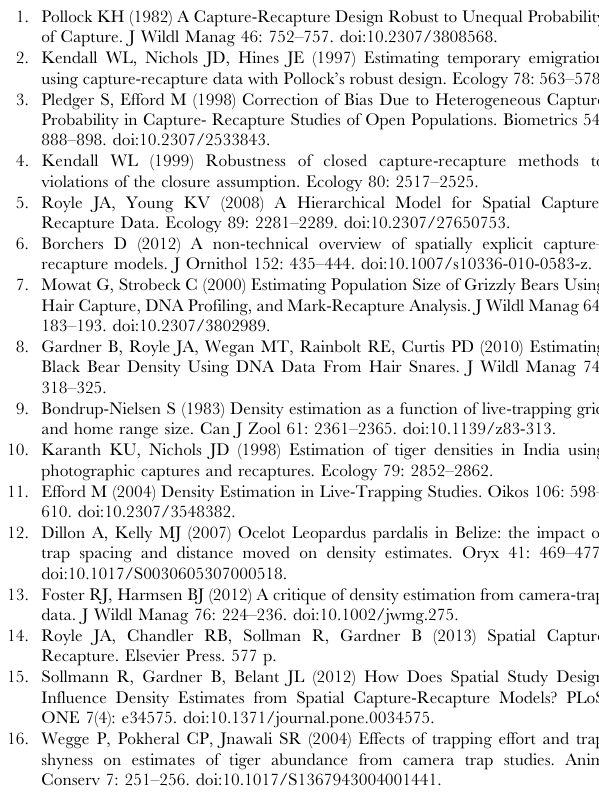
ing Tables S1–S9. Table S1 Custom-written R scripts for data simulation and parameter estimation. Table S2 in File S1. Summary of mean capture data across trap configuration, s , and p 0 for N= 500 and J= 128 traps. Table S3 in File S1. Summary of capture data across s and p 0 when trap spacing